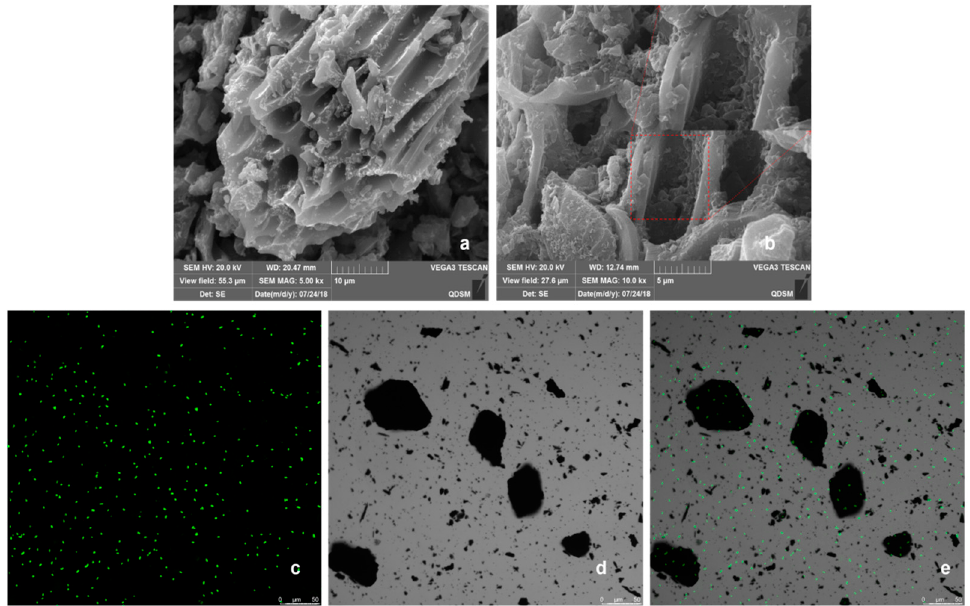
Figure 1. ESEM images of biochar treated with ( a ) 0.85% NaCl, ( b ) Tpb55-inoculated biochar, and fluorescent microscopy images of ( c ) Tpb55–pRP43 on biochar particle GFP excitation, ( d ) bright-field, and ( e ) an overlay of the bright-field and GFP image.